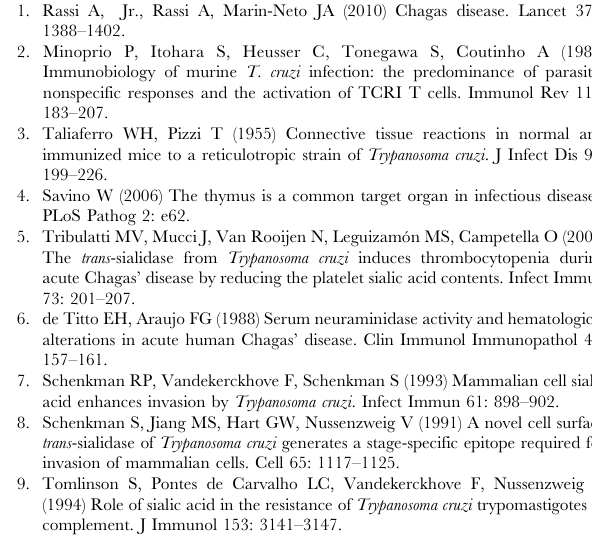
Figure S1 Production of the mAb 13G9-TS immuno- complex. A ) MonoQ-chromatogram of Protein A-purified hybridoma 13G9 supernatant. The mAb eluted as a single peak. B ) TS reactivity of eluted and pass-trough proteins. Nitrocellulose membranes were spotted with TS-SAPA native (1) or heat- denatured (2). Upper panel was tested with flow through proteins, middle panel with the eluted peak and lower panel with an anti- SAPA mAb. Filters were developed with an HRP-labeled secondary antibody against mouse immunoglobulins. Note the absence of reactivity to the denatured protein by the 13G9 mAb (middle panel, spot 2) in contrast with the anti-SAPA mAb